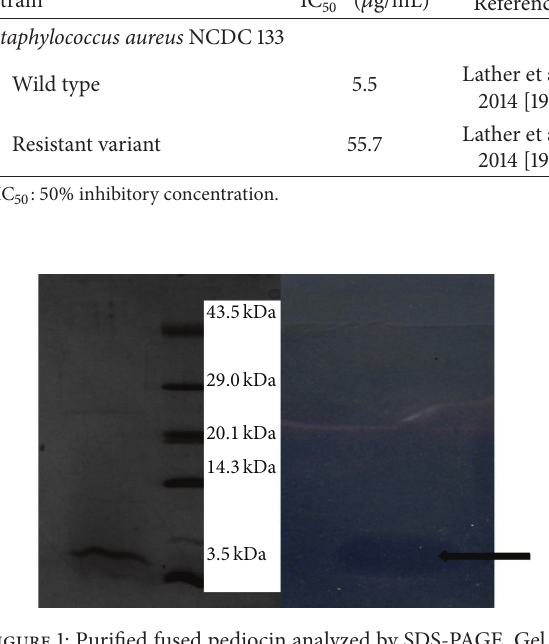
Figure 1: Purified fused pediocin analyzed by SDS-PAGE. Gel was removed and cut into two parts. One half, containing molecular weight marker (lane 2) and the purified pediocin, was stained with CBB R-250. The other half, containing the purified bacteriocin (lane 3), was overlaid with Staphylococcus aureus and incubated at 37 ∘ C for 16h. Arrow indicates bacteriocin